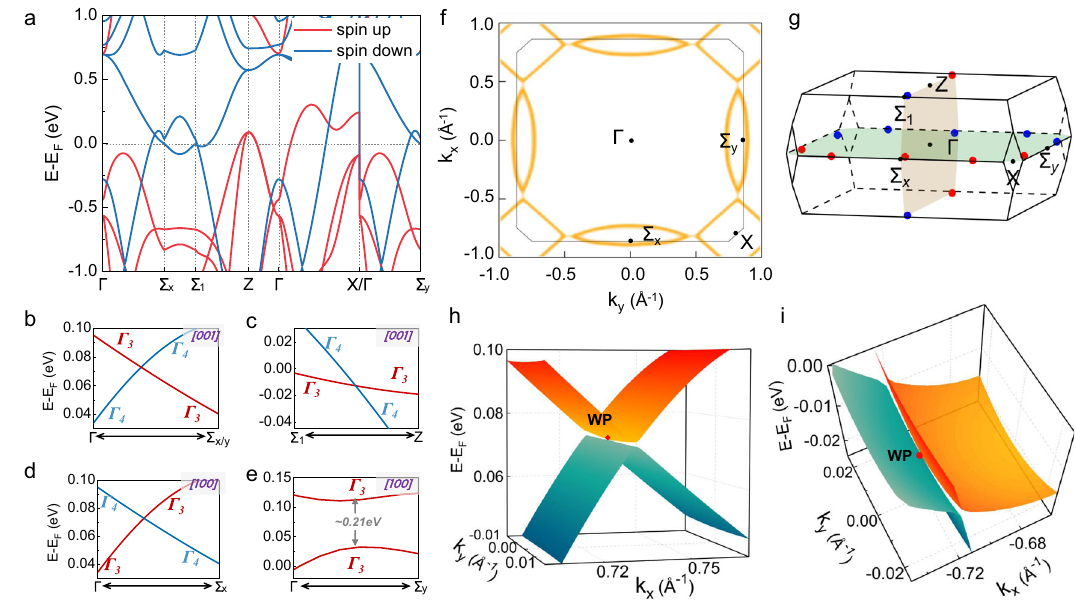
g The six pairs of Weyl points survive in the BZ when the applied magnetic fi eld along[100]direction. h , i showthetype-IWeylpointinthe Г – Σ x (or Г – Σ y )pathand the type-II Weyl point in Σ 1 -Z path,